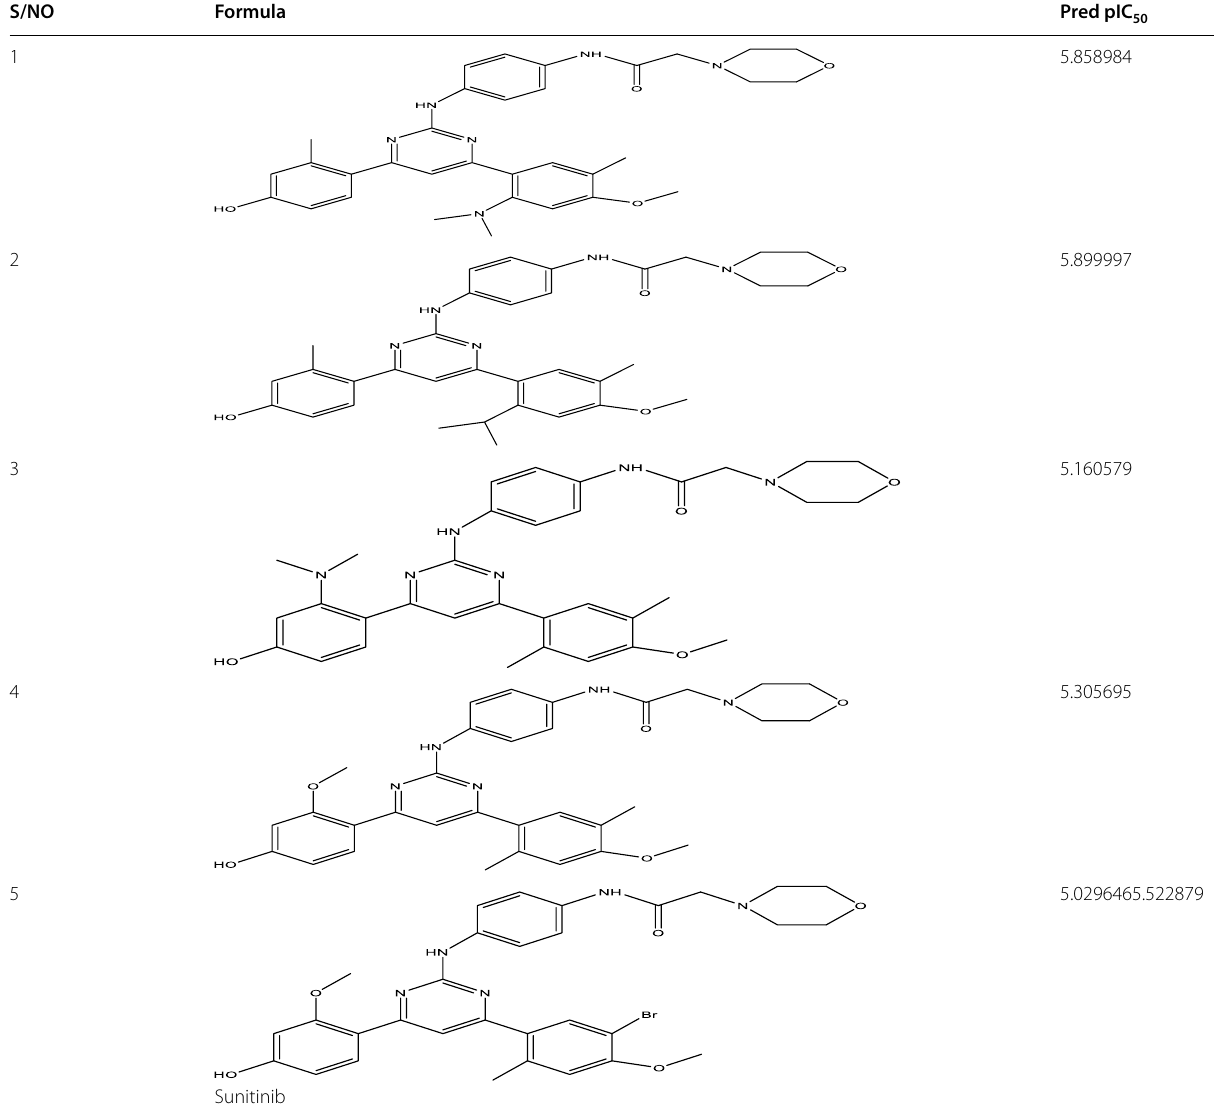
Table 5 2D structures, predicted activities of the designed of 4, 6-diaryl-2-pyrimidinamine derivatives